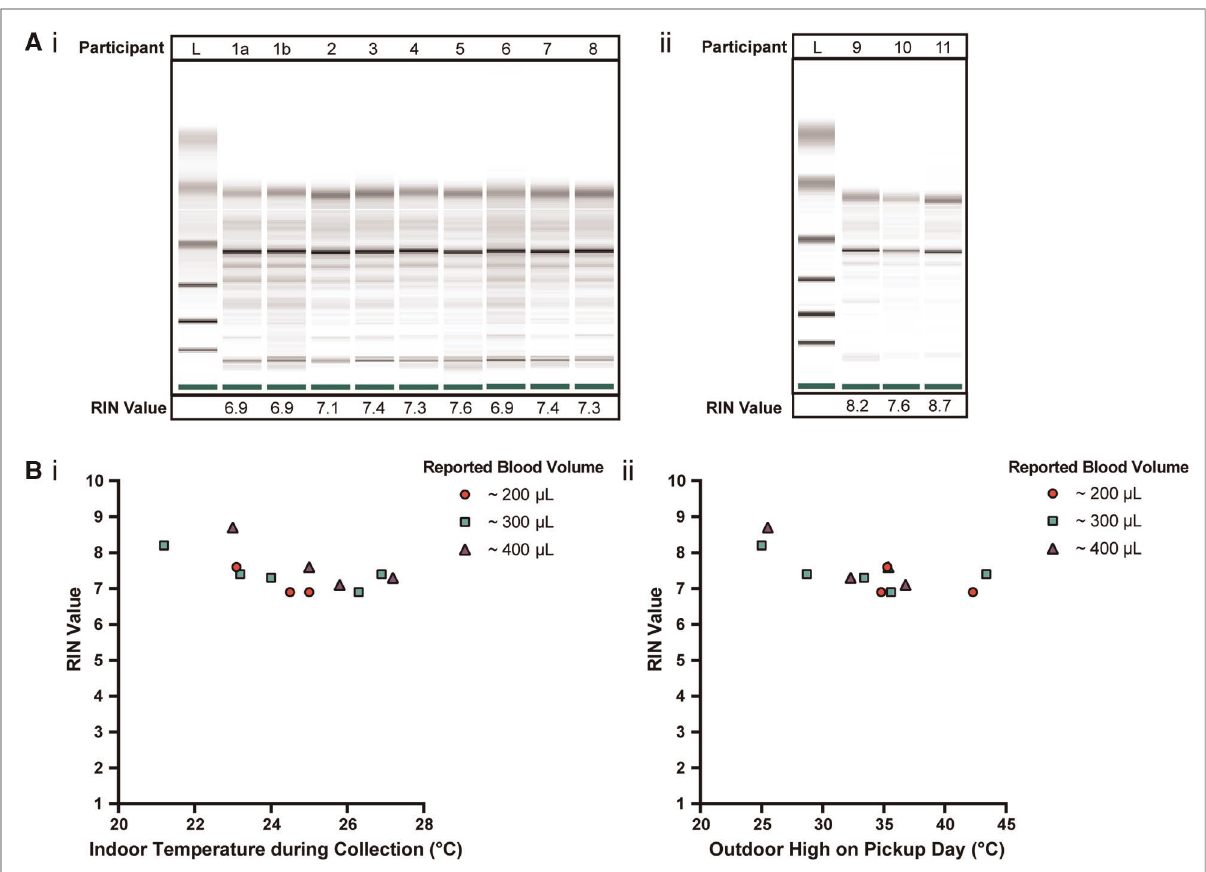
FIGURE 3 Quality of isolated RNA from stabilized home RNA samples collected during the summer in the Western and South Central USA. (A ) Digital gel image of RNA isolated from home RNA stabilized blood samples with corresponding RIN values, with (i) samples diluted 1:5 with nuclease-free water and run with a RNA 6000 Pico kit and (ii) samples run with a RNA 6000 Nano kit without dilution. Participant 1 contributed two samples, 1a and 1b, that were collected and stabilized on different days and at different temperatures. ( B ) (i) RIN values from blood collected and stabilized at different indoor ambient temperatures during summer and (ii) RIN values according to the outdoor temperature high reported on the day of collection. Each participant was asked to report the approximate blood volume collected before stabilization based on Supplementary Figure S6 in the collection